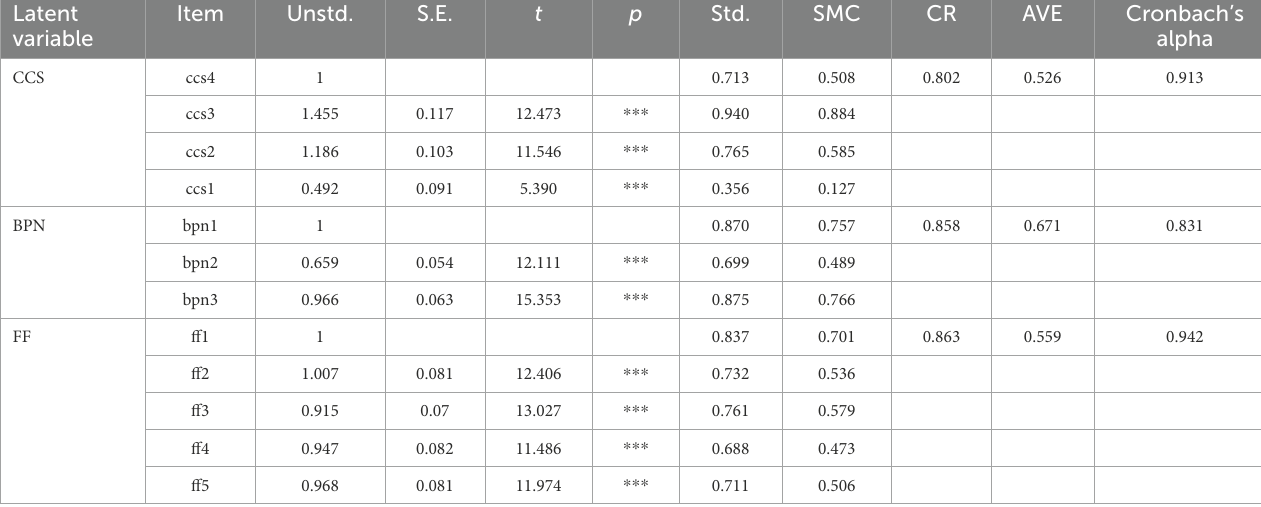
TABLE 4 Convergence